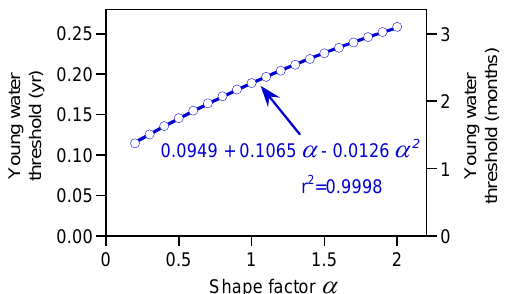
Figure 10. Best-fit young water thresholds for gamma transit-time distributions, as a function of shape factors α ranging from 0.2 to 2.0. The young water threshold τ yw is defined such that the frac- tion of the distribution with ages less than τ yw approximately equals the amplitude ratio ( A S /A P ) of annual cycles in streamflow and pre- cipitation (see Fig.